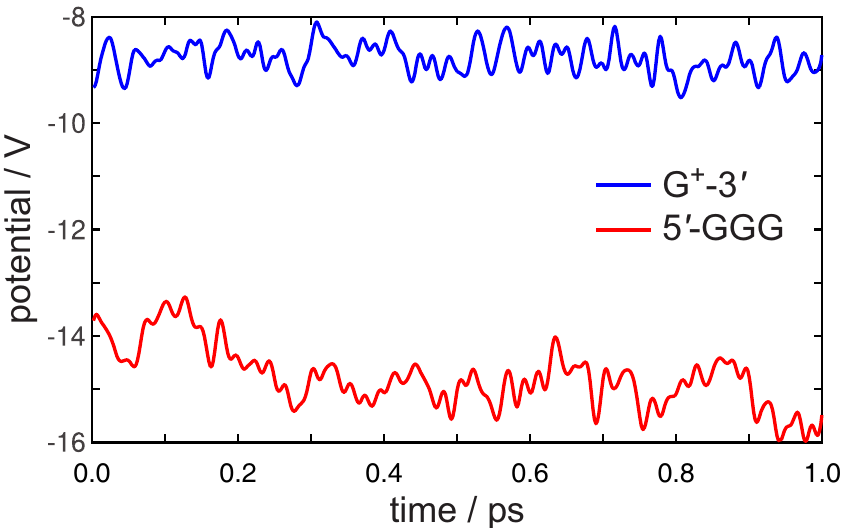
Figure 6. Electrostatic potential fluctuations at the G-3 (cid:48) site (blue line) and 5 (cid:48) -GGG nucleobase stack (red line) for the initial 100 fs dynamics for ds-5 (cid:48) -GGGTG-3 (cid:48) B-DNA sequence. Averages over 3 simulations are reported. The hole is localized at G-3 (cid:48) .